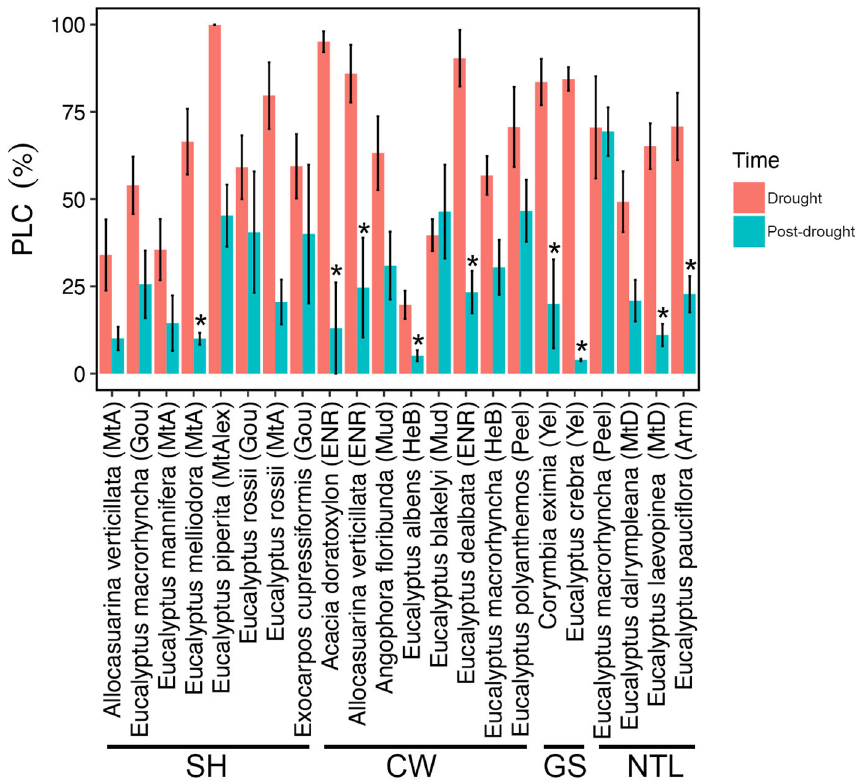
Figure 3. Percent loss of conductivity (PLC, %) during drought (red) and post-drought (light blue) for each species understudy. For each species, the abbreviation in brackets indicates the sampling site (please see Table 1). Species are grouped according to the sampling region: Southern Highlands (SH), Central West (CW), Greater Sydney (GS) and Northern Table Lands (NTL) (see Table 1 for site abbreviations). Values shown are means ± SE (n = 2–10; see also Table S1). Asterisks indicate significant differences (P < 0.05) between PLC measured before and after the